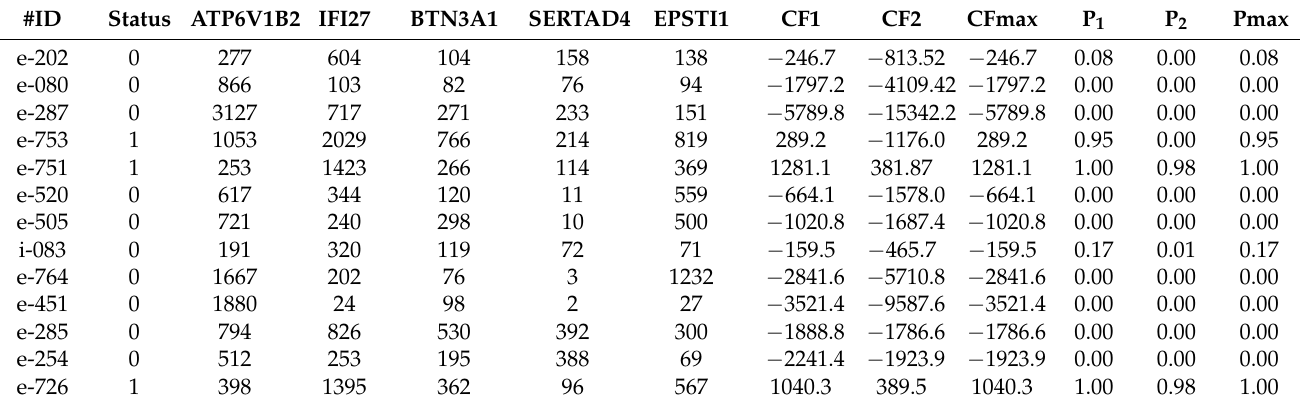
Table 6. First dataset: Expression values of the five critical genes, competing classifier factors and predicted probabilities.